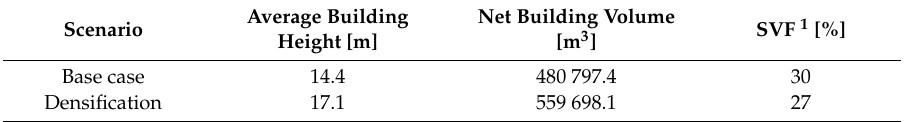
Table 4. Overview of the location-specific features of the base case and the densification scenario.